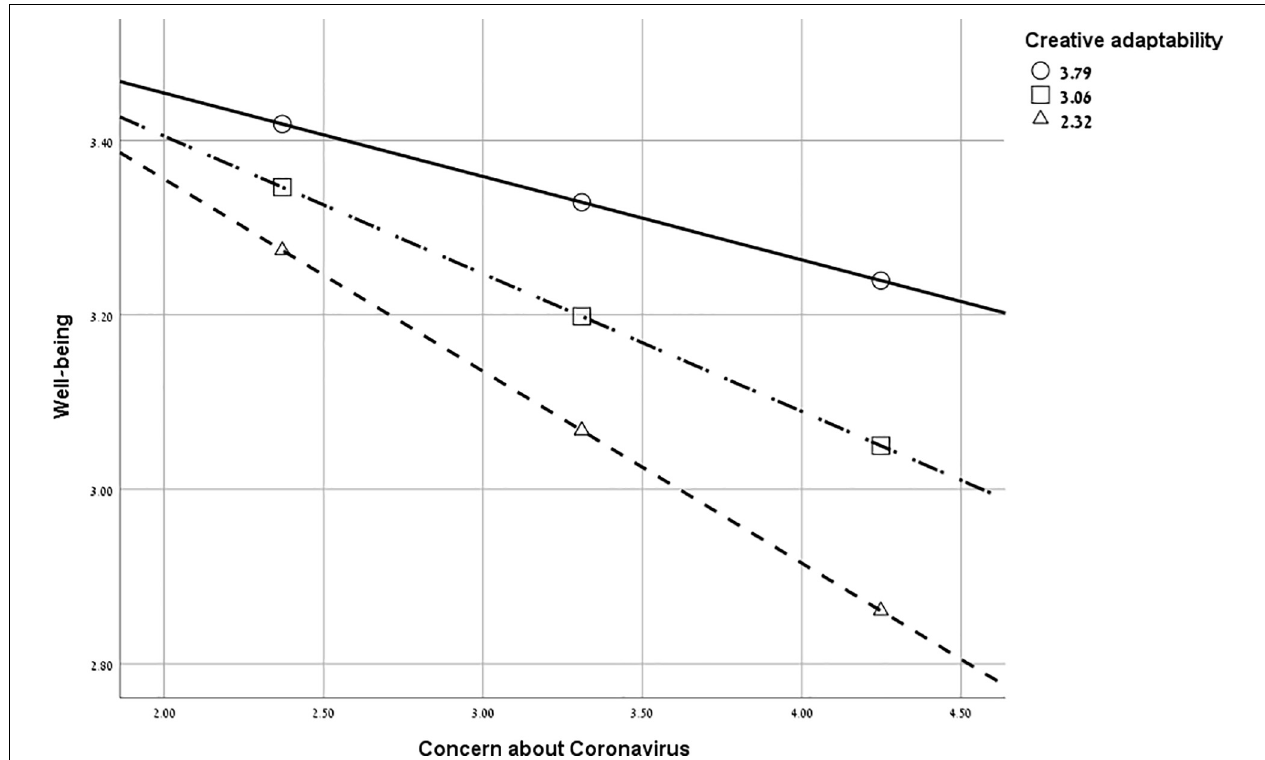
FIGURE 2 | Moderation analysis. Creative adaptability moderates the effect of concern about Coronavirus on well-being.